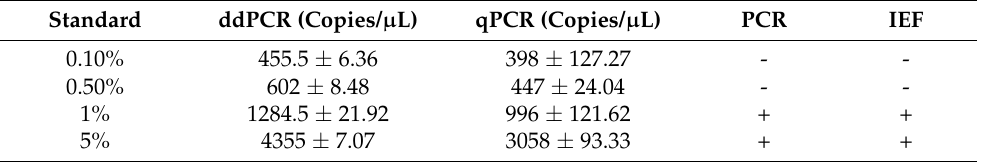
Table 2. ddPCR, qPCR, IEF, and HPLC-UV of buffalo mozzarella cheese samples. Table 3. Target copies (copies/ µ L) or Ct detected by ddPCR, qPCR, PCR, and IEF in standard Sample n.